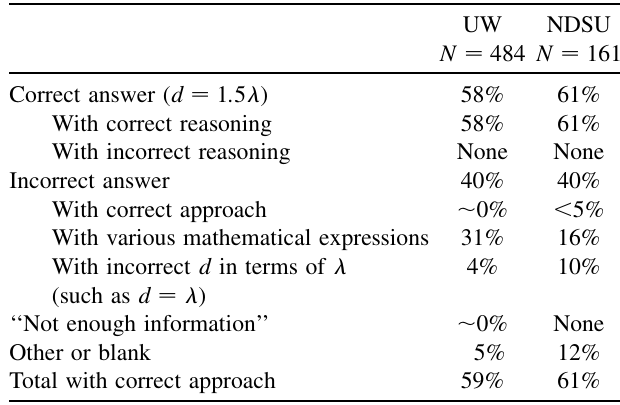
TABLE IV. Summary of results from the slit separation task after all instruction on two-source